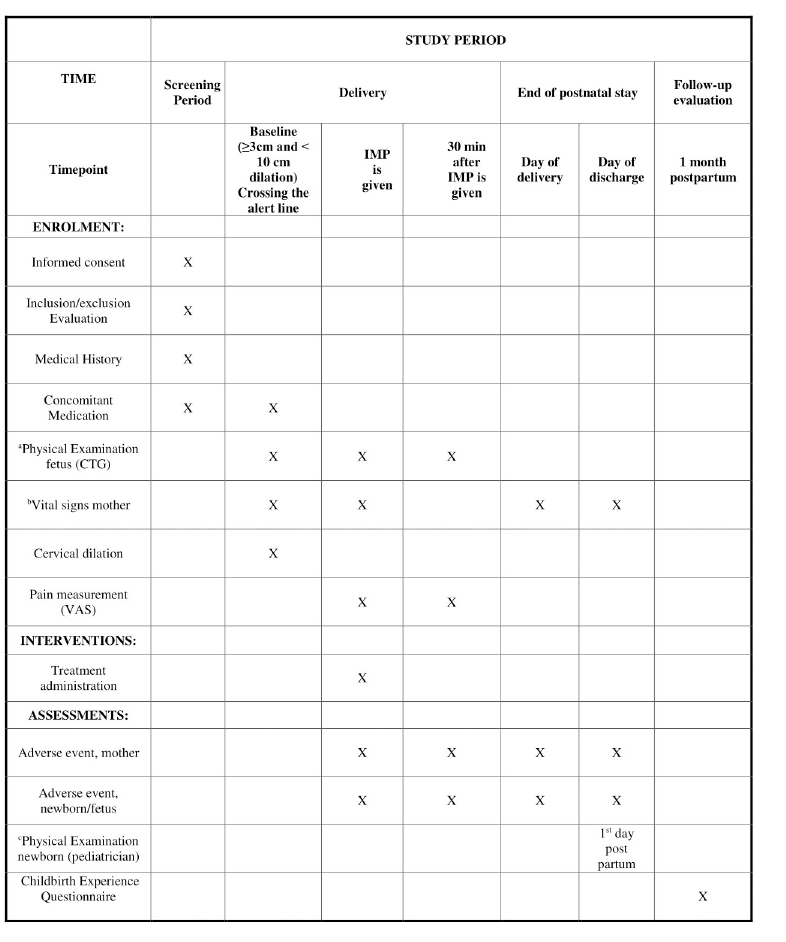
Fig 1. Schedule of enrollment, intervention and assessments. IMP = Investigational Medicinal Product. CTG = Cardiotocography—continuous fetal heart tracing. VAS = Visual Analogue Scale. a Physical Examination fetus includes fetal position and CTG—continuous fetal heart tracing b Vital signs include maternal blood pressure and heart rate. Height and body weight are obtained from pregnancy charts c Physical Examination newborn includes an examination of general